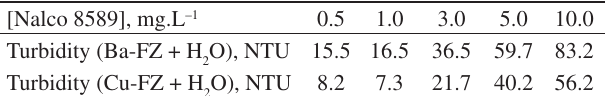
O) and (Cu-FZ + H O). 2 2